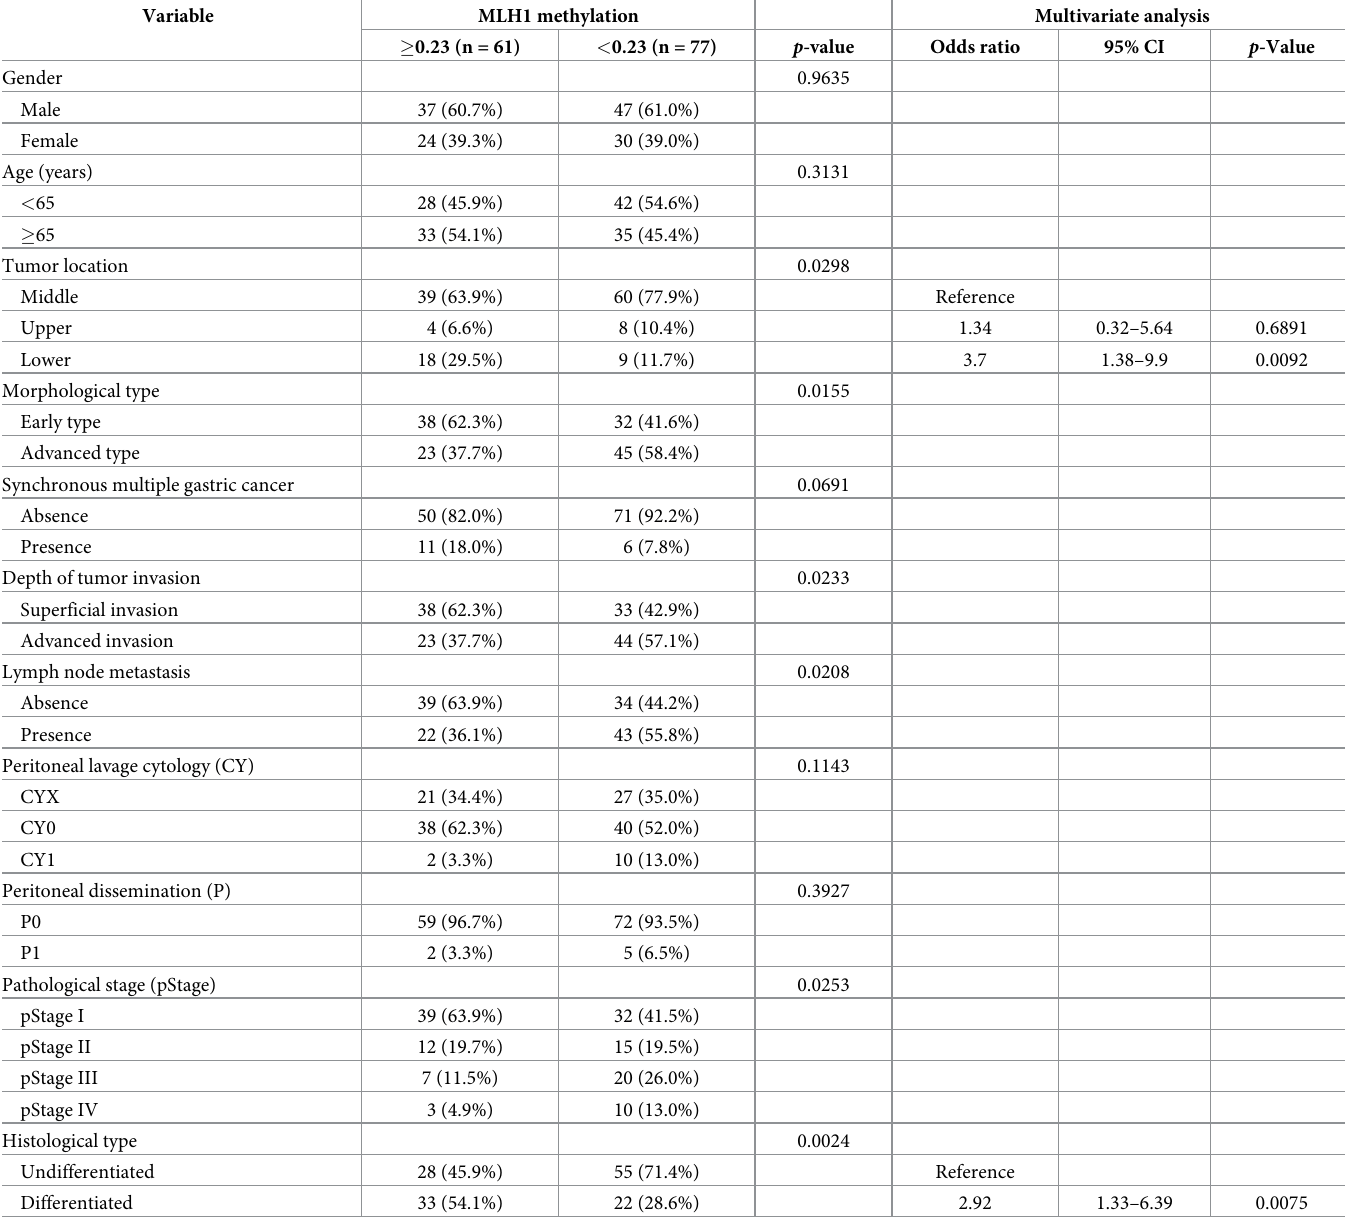
Table 1. Correlation between clinicopathological factors and MLH1 methylation status divided by cutoff value of 0.23 in primary gastric